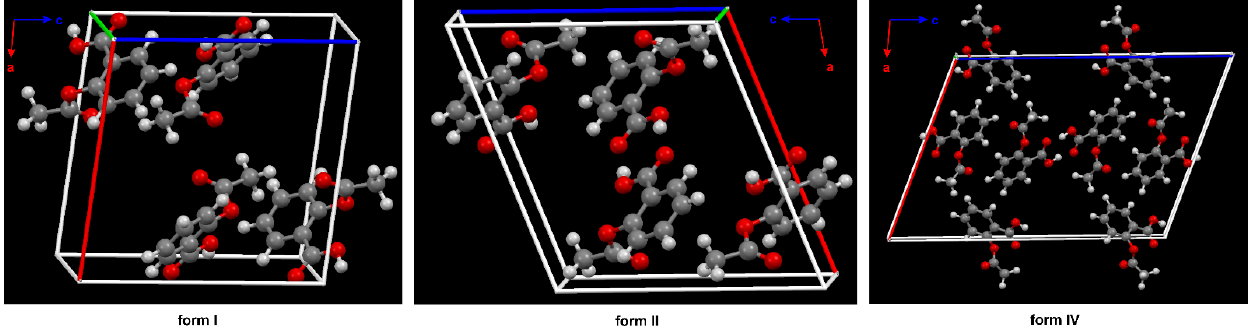
Figure 2. The crystal packing of ASA, form I (CSD refcode: ACSALA), form II (CSD refcode: ACSALA13) and form IV (CSD refcode: ACSALA24) along the b axis; formed through O–H ···O hydrogen bonds. The key difference between the structures I and II lies in the way the layers are arranged and bonded. Form I shows molecules in direct contact across the layer boundary forming the hydrogen bonded centrosymmetric acetyl groups (Ac) dimer. Form II shows the contraccatemericCO 2 H dimer and interlayer acid dimers are connected via catemeric methyl C–H ··· O and phenyl C–H ··· O hydro- gen bonds interactions. The two arrangements are related to each other by a relative shift of adjacent layers along the crystallographic c axis in space group P21/c. The known crystal structure of ASA. In the structure of form IV, the plane of the Ac group is nearly perpendicular to the aryl ring plane, as in form I and II (see Figure 1). Color code: H = white, C = grey, O = red.